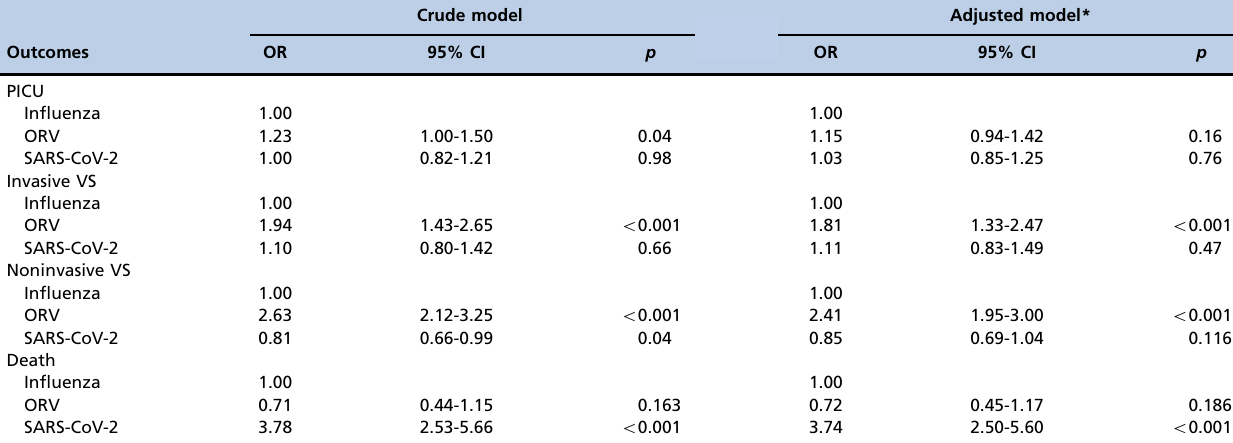
Table 2 - Risk of negative outcomes according to viral agent in pediatric patients with severe acute respiratory